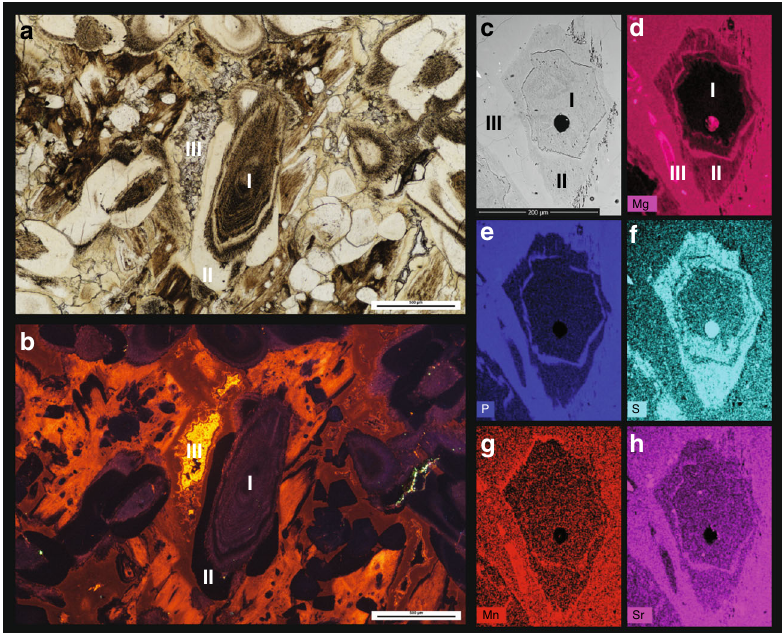
Fig. 3 Glendonite thin-section photomicrographs. a Thin section of a glendonite from the + 60 – 62 horizon under plane polarised light. b The same view under cathodoluminescence. The three main calcite phases (types I, II and III, as de fi ned in Vickers et al. 12 ) are clearly distinct, showing different luminescent properties. c Secondary Electron SEM image of thin section of glendonite from the + 15 horizon. d – h Element maps (by Energy Dispersive X- Ray Spectroscopy, EDS) of the same view, showing Mg, Mn, P, S and Sr variations. I = Type I calcite, the ikaite-derived calcite phase in glendonite; II = secondary calcites, collectively called Type II calcite, believed to have grown rapidly on the Type I calcite after transformation of the ikaite to calcite; III =